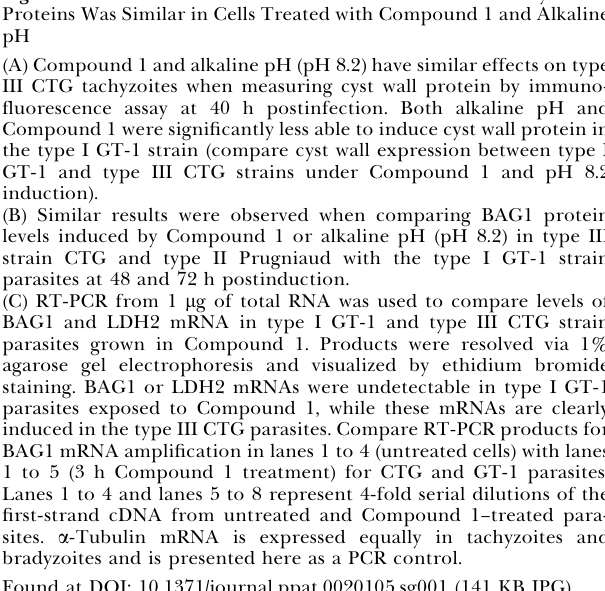
Figure S2. Assessment of p38 MAPK Activation in Compound 1– Induced Parasite Development (A) LPS (100 ng/ml) and PMA (20 ng/ml and ionomycin 0.5 l g/ml) were unable to induce significant phosphorylation of p38 MAPK in HFF as measured by anti–phospho-p38 antibodies and Western blot. Compare untreated cell lysates, labeled C, with those from cells treated from 10 min to 24 h. In contrast, anisomycin (10 l g/ml) was able to induce significant levels of phosphorylated p38 in these cell types, and as early as 15 min post-treatment. Parasite infection alone was unable to induce phosphorylation of p38 (compare lysates from